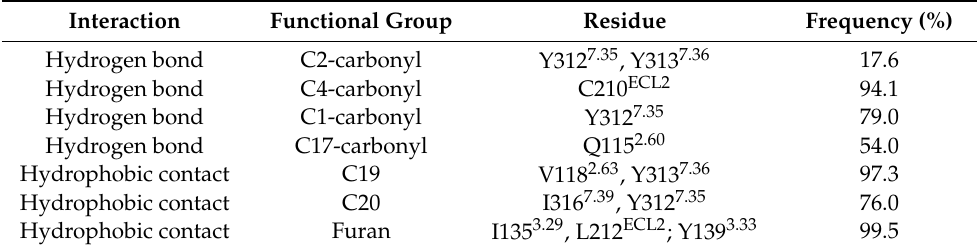
Table 2. Interactions between SalA and the KOR during MD